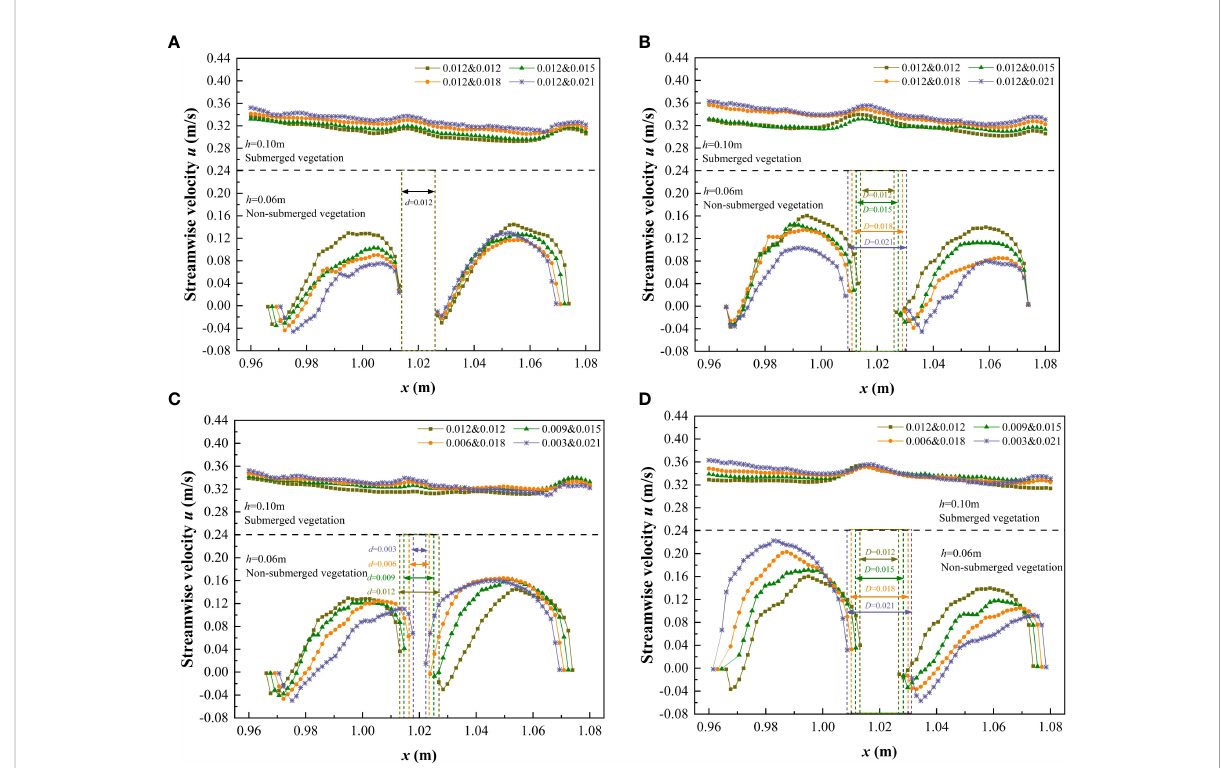
FIGURE 5 Variation streamwise velocity before and after a single vegetation ( h = 0.06 m and 0.10 m) under different submerged conditions. (A) L 1 , vegetation combination distribution, (B) L 2 , vegetation combination distribution, (C) L 1 , vegetation discrete distribution, (D) L 2 , vegetation discrete